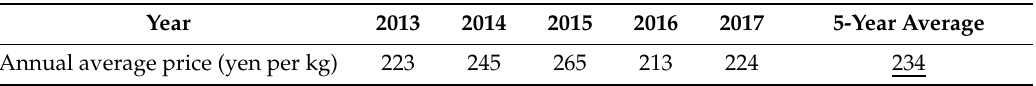
Table 6. Using the 5-year average price, the revenue of corn grown in the di ff erent configurations was calculated (Table 7). Table 6. Annual average price of sweetcorn in Tokyo Metropolitan Central Wholesale Market from 2013 to 2017. Source: Agriculture & Livestock Industries Corporation (2018).